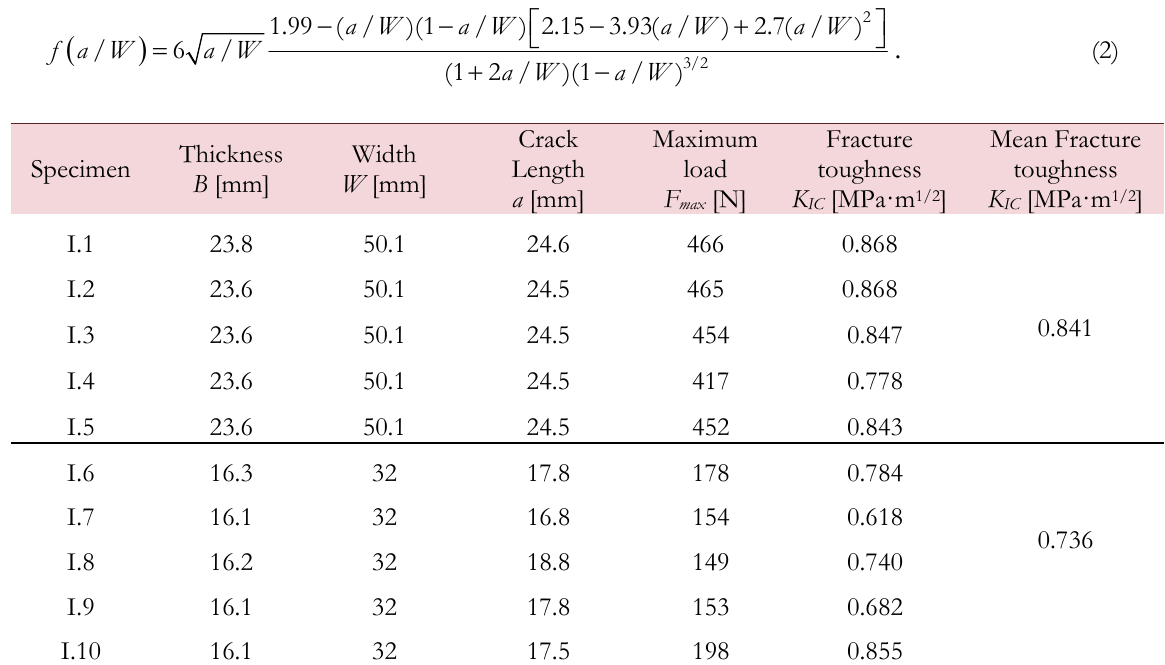
Table 1: Mode I fracture toughness